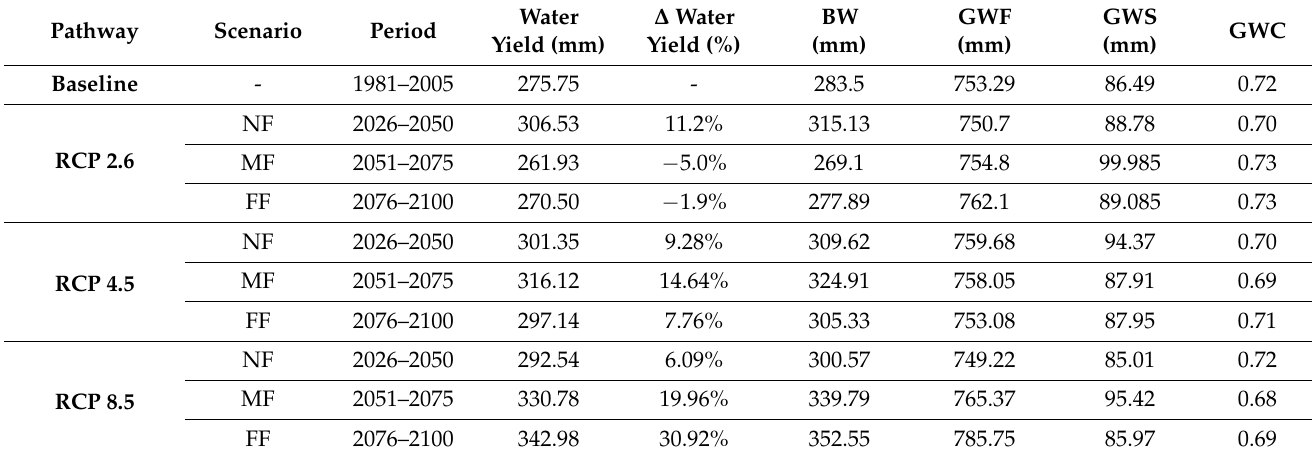
Table 5. Water regulation indicators: Water Yield (variation and mean values ex-pressed in percentage), Blue Water (BW), Green Water Flow (GWF), Green Water Storage (GWS) and Green Water Coefficient (GWC) in comparison to the three different projected periods for all RCPs and both models